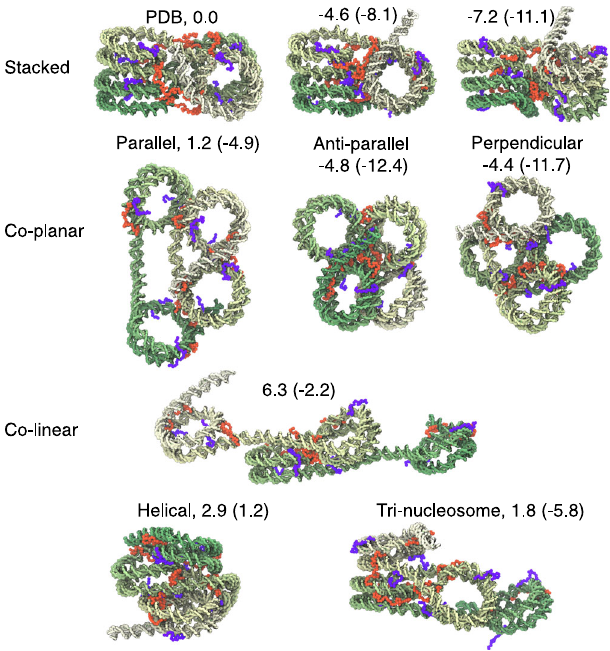
Fig. 2 Representative tetra-nucleosome con fi gurations from K-means clustering. See Supplementary Movie 1 for the full set of cluster structures. For clarity, only the DNA molecule, the color of which varies from green to white, is shown. The N-terminal tails of histone H3 and H4 protein are drawn in purple and orange, respectively. The numbers indicate their stability relative to the PDB structure (top left) measured in the unit of kcal/mol, and were evaluated using simulations performed with the presence of protein – protein interactions between nucleosomes. The corresponding values inside the parentheses were obtained using simulations performed without such